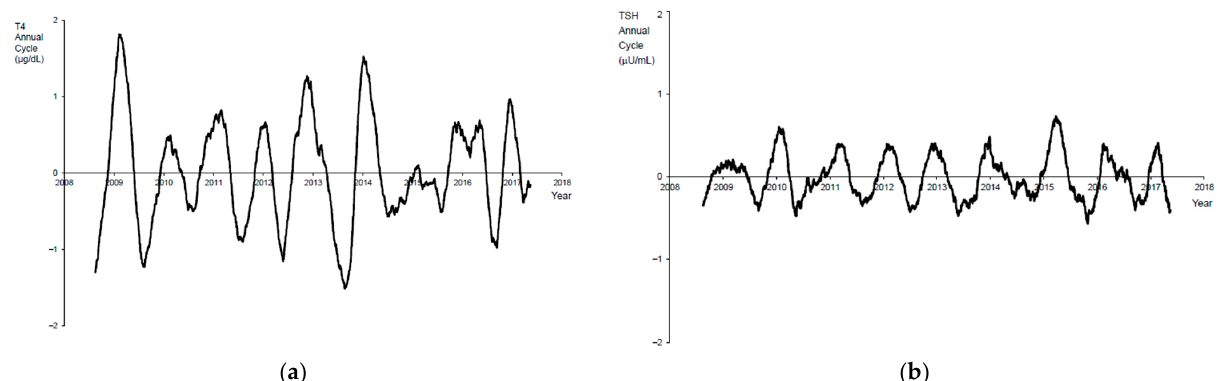
Figure 3. ( a ) Time series analysis isolating the annual cycle component of the T4 series. Note the cyclical seasonal pattern. ( b ) Time series analysis isolating the annual cycle component of the TSH series. Note the cyclical seasonal pattern.